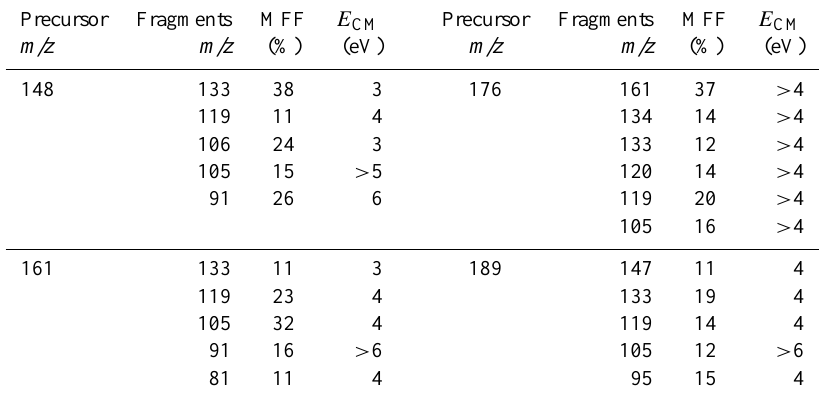
Table 3. Fragment ions with maximum fragmentation fraction > 10% from the fragmentation of CI fragment ions from the reaction between β -caryophyllene and NO + .